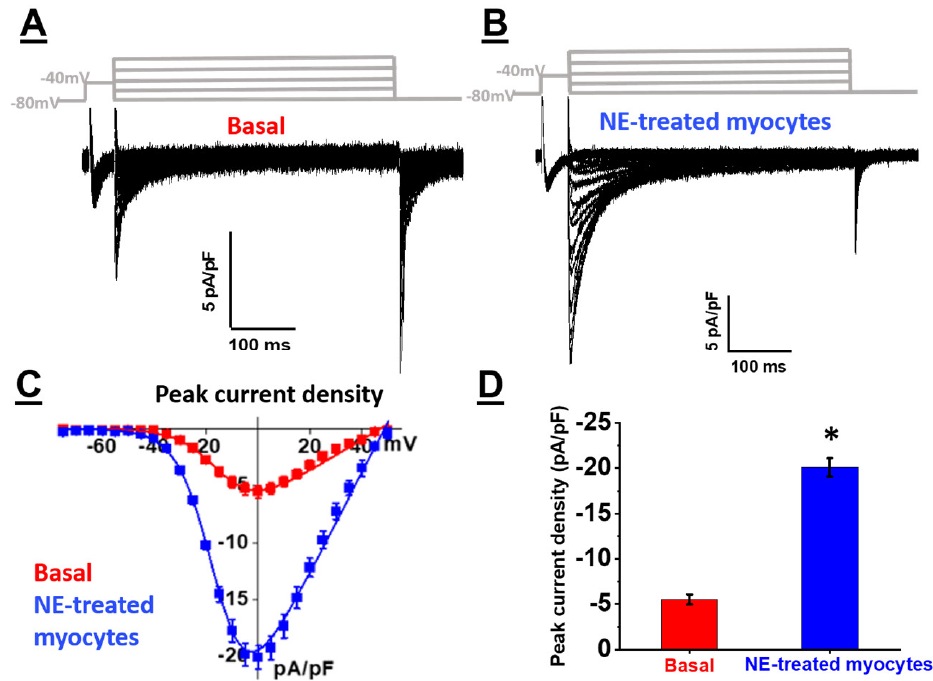
Figure 2. ( A , B ) Representative whole-cell Ca 2+ current traces were recorded from neonatal rat cardiomyocytes under basal conditions (in red) or were treated with 1 µ M norepinephrine (NE) for 24 h (in blue). In all cases, the cells were bathed in a saline physiological solution containing 2 mM Ca 2+ in the absence of NE. The pulse protocol is shown above the traces. Currents were elicited from a holding potential of − 80 mV and recorded at potentials ranging from − 80 to 50 mV in 5 mV increments. Na + currents were suppressed by applying a 40 ms prepulse to − 40 mV as shown in the inset above the current traces. ( C ) Mean current-voltage relationships of whole-cell Ca 2+ currents recorded from neonatal rat cardiomyocytes (NRVMs). Current densities were obtained by normalizing whole-cell current amplitudes to the membrane capacitance and were plotted versus applied voltages. The Boltzman analysis of Ca 2+ channel activation voltage yielded a mid-point of activation at V 1/2 = − 14 ± 1 mV (mean ± S.E.) ( n = 9, N = 2 repetitions) under basal conditions, and a mid-point of activation at V 1/2 = − 16 ± 1 mV ( n = 5, N = 2 repetitions) for NE-treated NRVMs ( p = 0.13). Experiments were carried out with 2 distinct cell preparations, and the total number of cells that were patched were pooled. ( D ) Bar graph of the average peak current density of basal and NE-treated groups. The NE-treated group displays a 4-fold increase in the peak current density compared with that of the basal currents ( − 20 ± 1 pA/pF for NE-treated vs. − 5.5 ± 0.6 pA/pF for basal, * p <